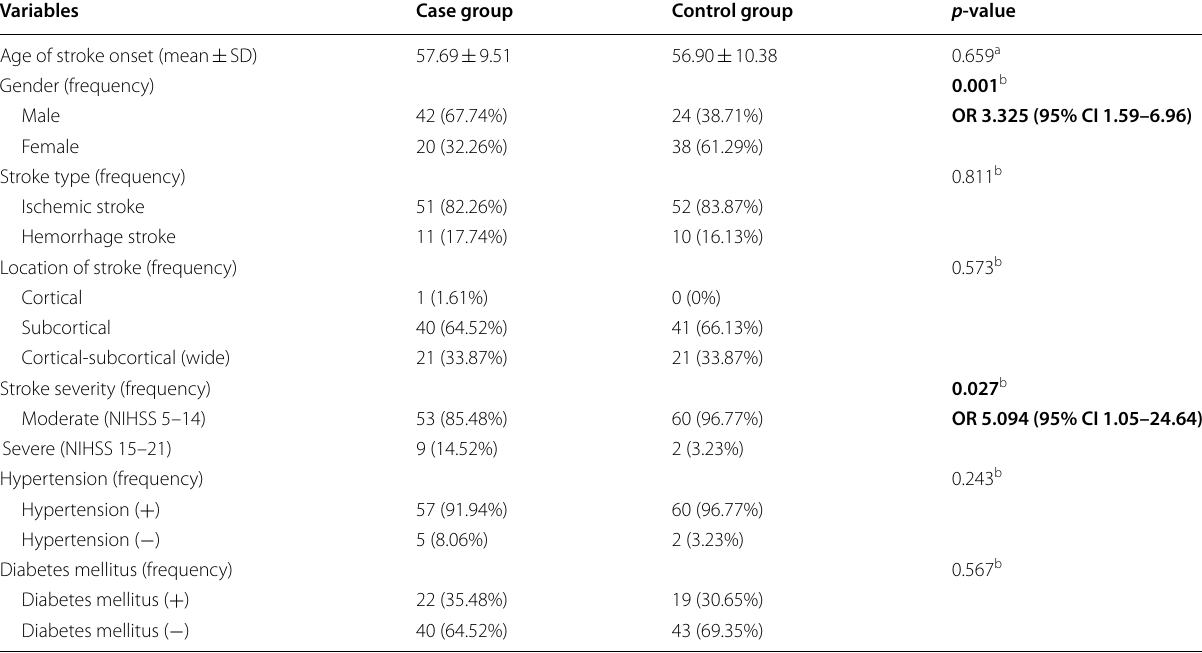
a Analyzed with independent T -test b Analyzed with Χ 2 ; bold: statistically significant ( p < 0.05)